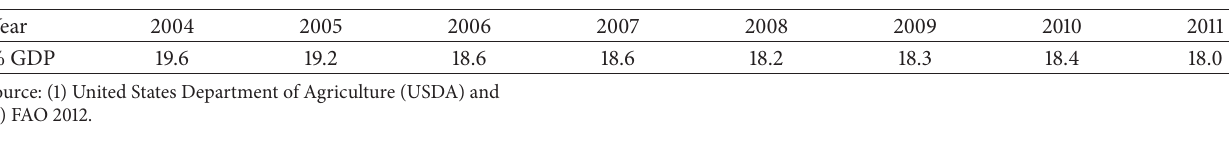
Table 3: Average annual growth rates of agriculture